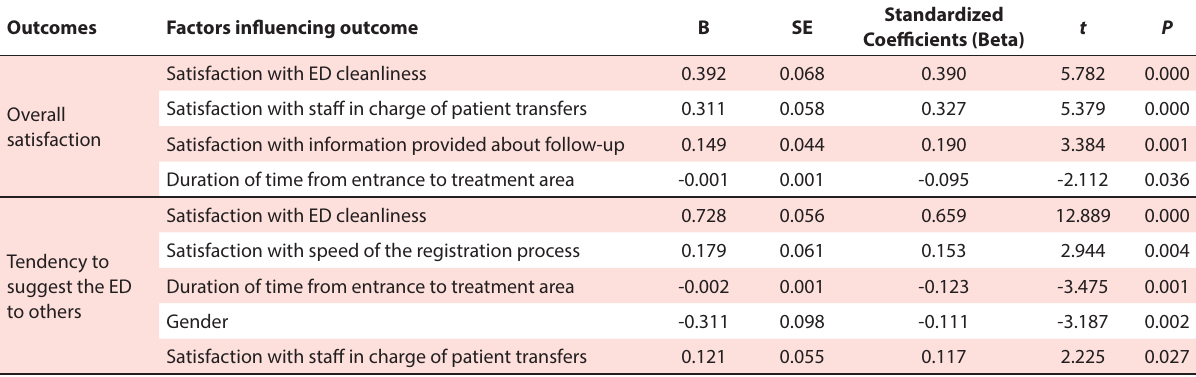
Table 3. Factors influencing outcomes based on linear regression analysis